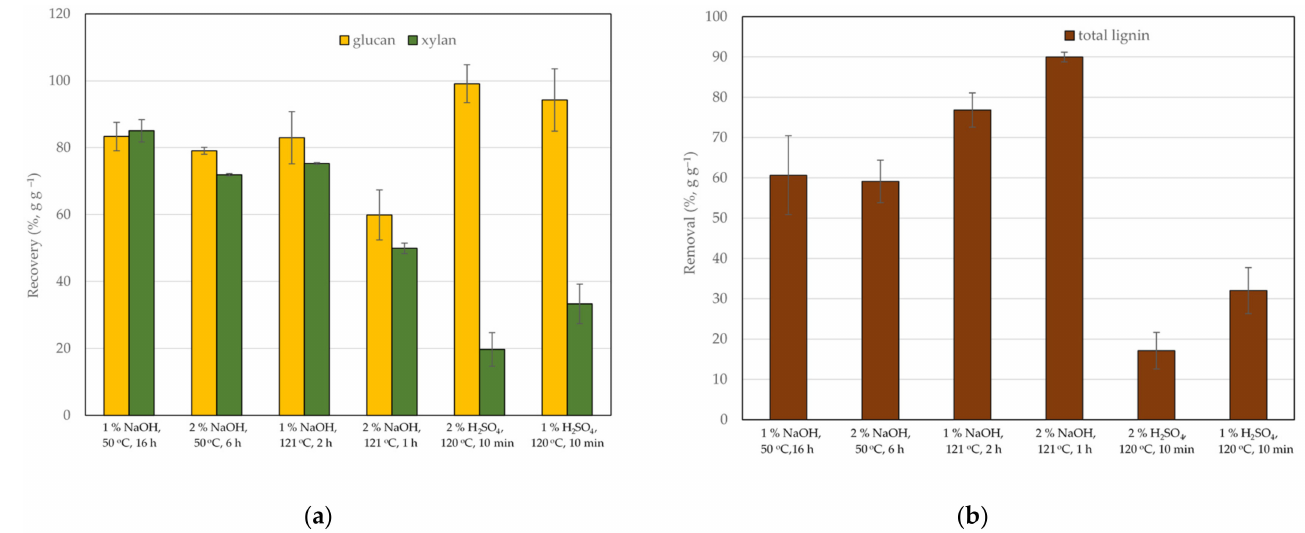
Figure 1. Recovery of glucan and xylan ( a ) and lignin removal ( b ) from pretreated corn cobs relative to the raw corn cobs. The error bars present the standard deviation of values from two independent